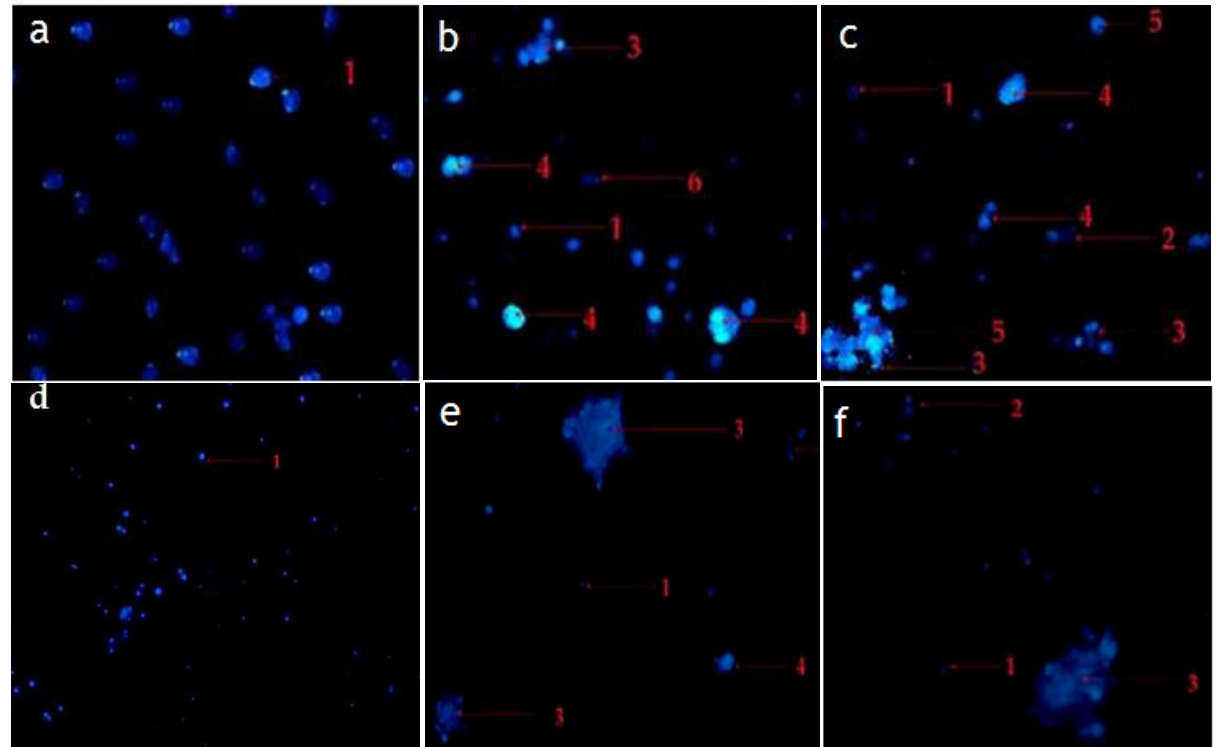
Figure 7. Morphological changes of selected RMS and MCF-7 cancer cells. RMS cells treated with ( a ): control (untreated cells); ( b ): standard cycloheximide (15 μg/mL); ( c ): standard cycloheximide (30 μg/mL). MCF-7 cells treated with ( d ): control (untreated cells); ( e ): standard cycloheximide (15 μg/mL); ( f) : standard cycloheximide (30 μg/mL) for 24 h and imaged via the Hoechst 33342 staining method (magnification 200×).